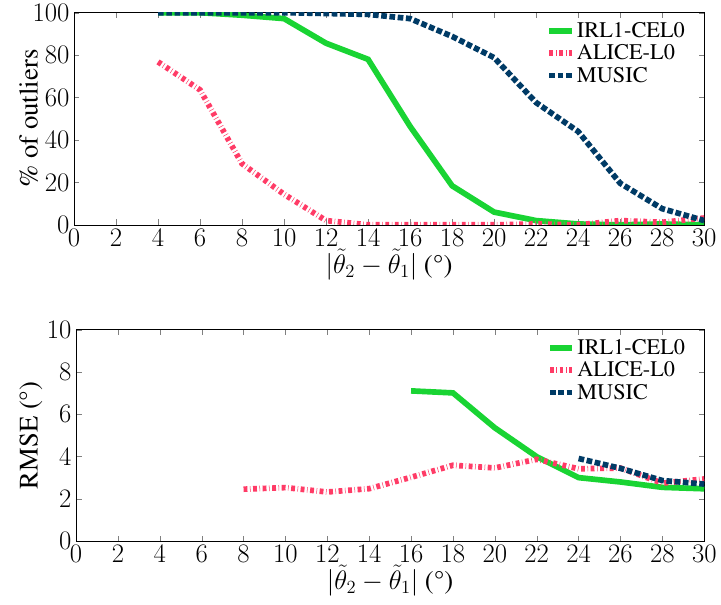
Figure 4. Performance as a function of the sources separation: percentage of outliers and RMSE (not reported when having more than 50% outliers). The regularization parameter λ is fixed to 0.78 according to the theoretical analysis